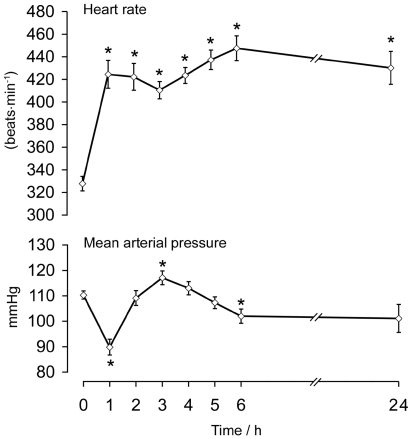
Heart rate and mean arterial pressure during continuous LPS infusion.Values are mean±SEM; n = 6 animals. * significantly different from baseline (P<0.05).